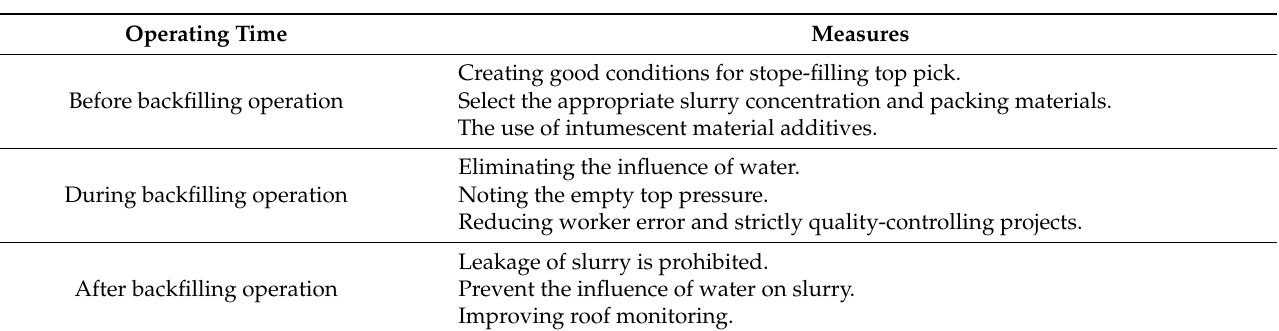
Table 3. Ways to improve management.